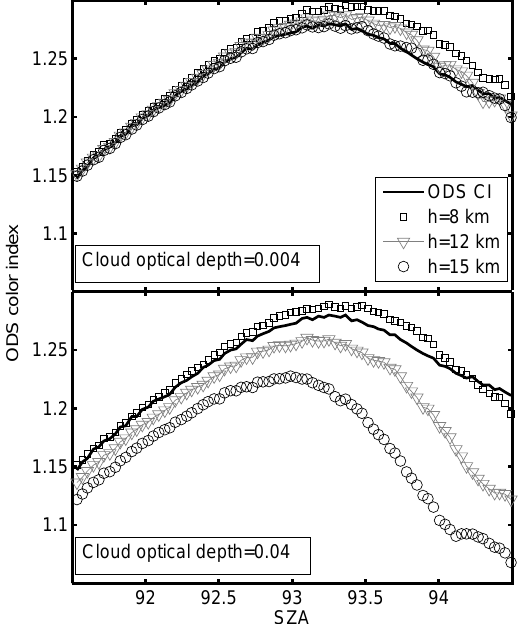
Figure 10. (a) ODS color index (black solid line) during sunset for one day of the campaign and simulated color index for COD = 0 . 004 and cloud altitude h = 8, 12 and 15km. (b) Same as (a) but for COD = 0 . 04. The simulated CI for COD = 0 . 004 and h = 15km fits better with the ODS-measured CI.